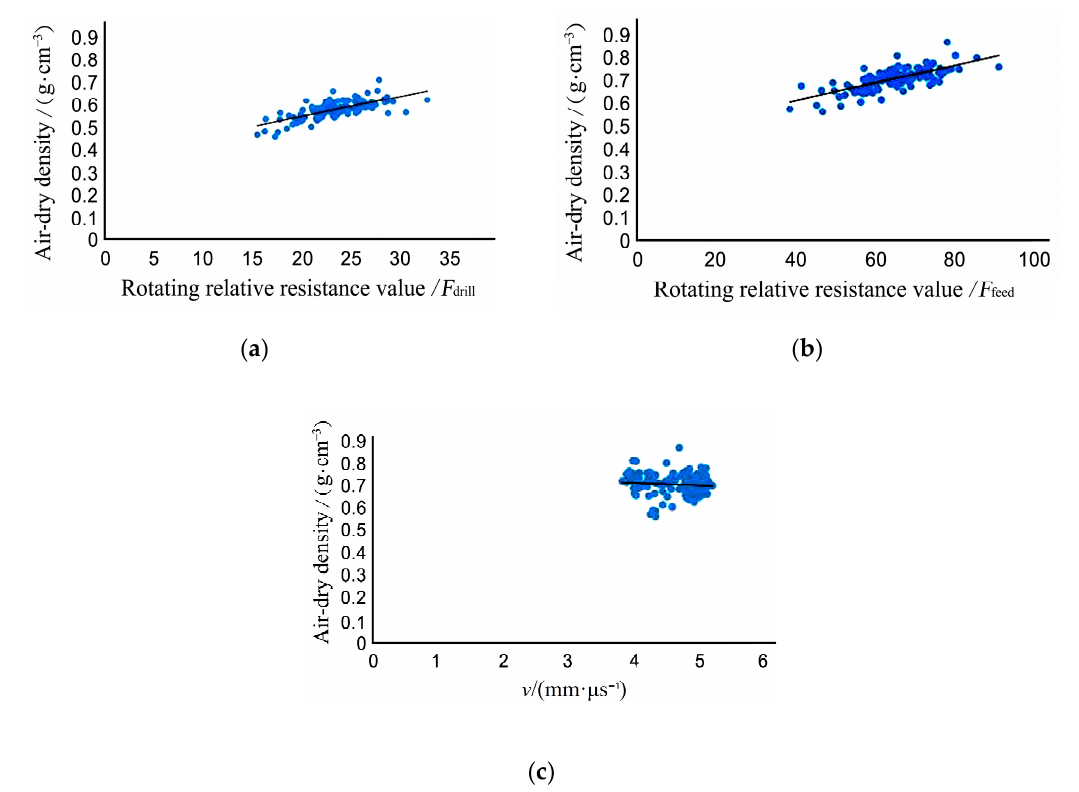
Figure 13. Relationship between density and nondestructive testing of small specimens: ( a ) Resistance values ( F drill ) and density; ( b ) Resistance values ( F feed ) and density; ( c ) Wave velocity and density.